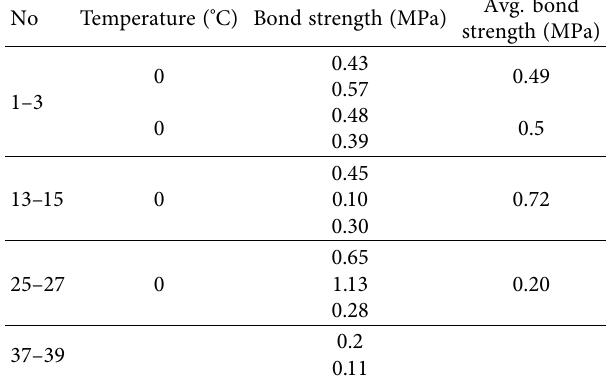
Table 3: Bonding